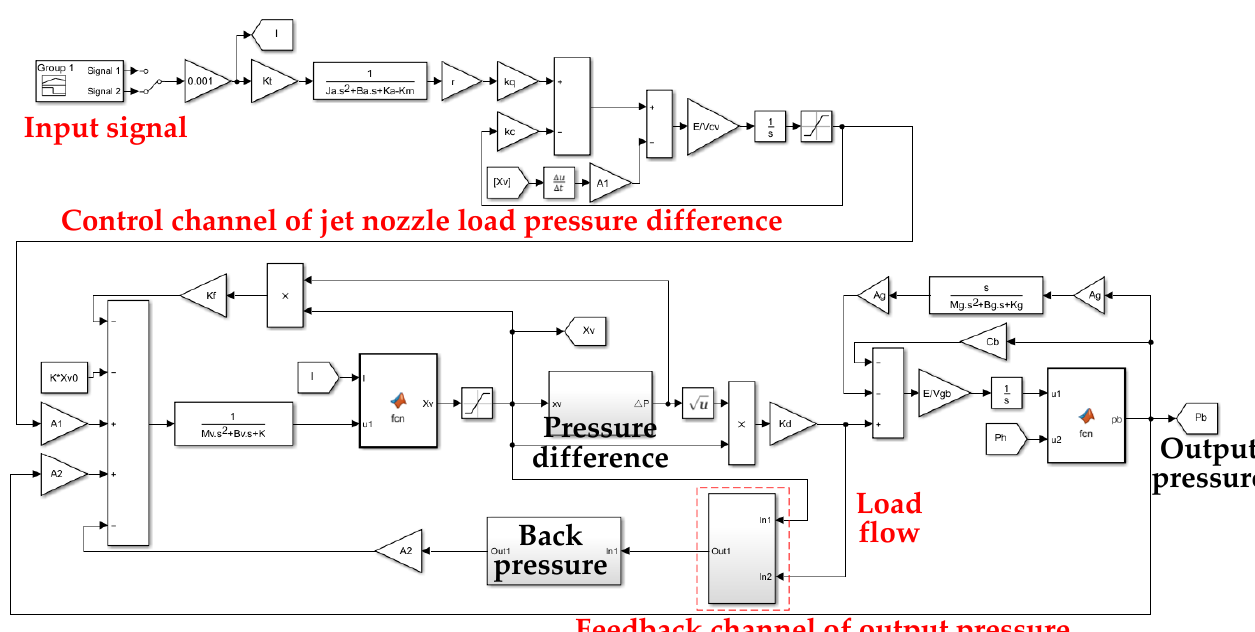
Figure 4. The structure schematic diagram of the pressure servo valve.